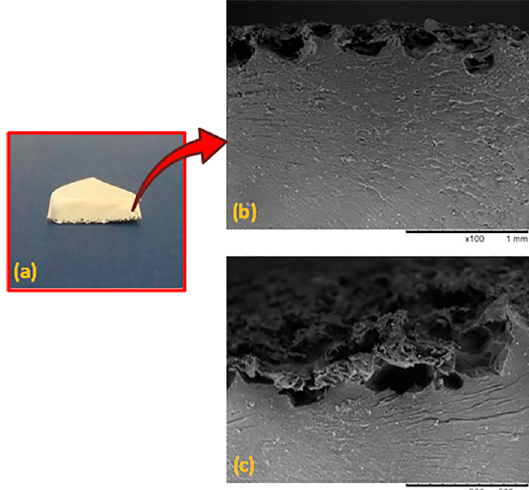
Figure 2. Micrographs of the cross section of the sample, observed without magnification (a), with magnification of 100 (b) and 200x